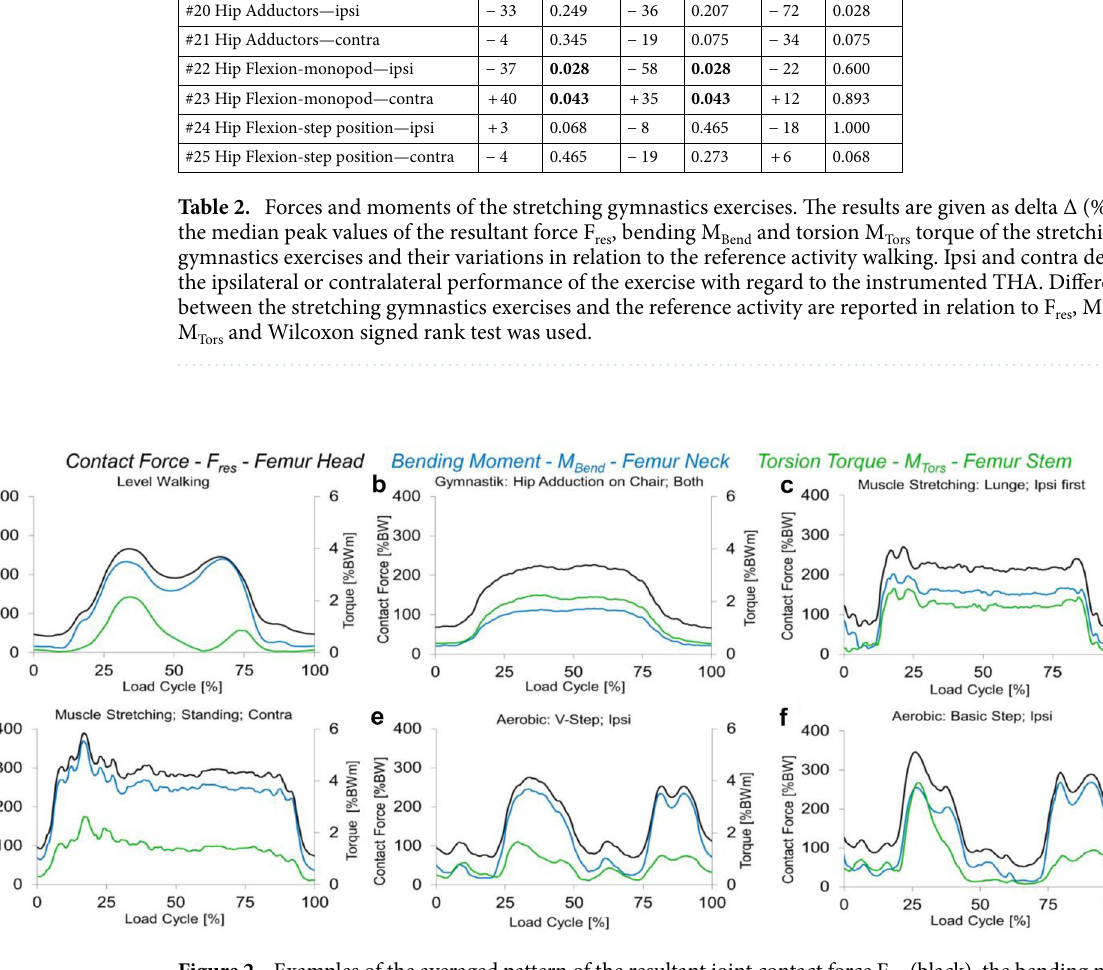
Figure 2. Examples of the averaged pattern of the resultant joint contact force F res (black), the bending moment at the femur neck M bend (blue) and torsion torque around the femur axis M tors (green); ( a ) during walking as reference activity #1; ( b ) hip adduction on chair #8, ( c ) hip flexion step ipsilateral #24, ( d ) hip flexion-monopod position contralateral #23, ( e ) V-step ipsilateral #28, and ( f ) basic step ipsilateral